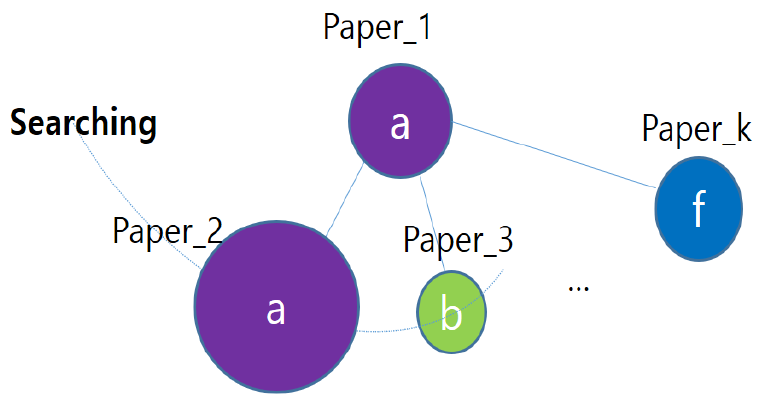
Figure 3. The concept of impact analysis. Node Color means the field of the papers.